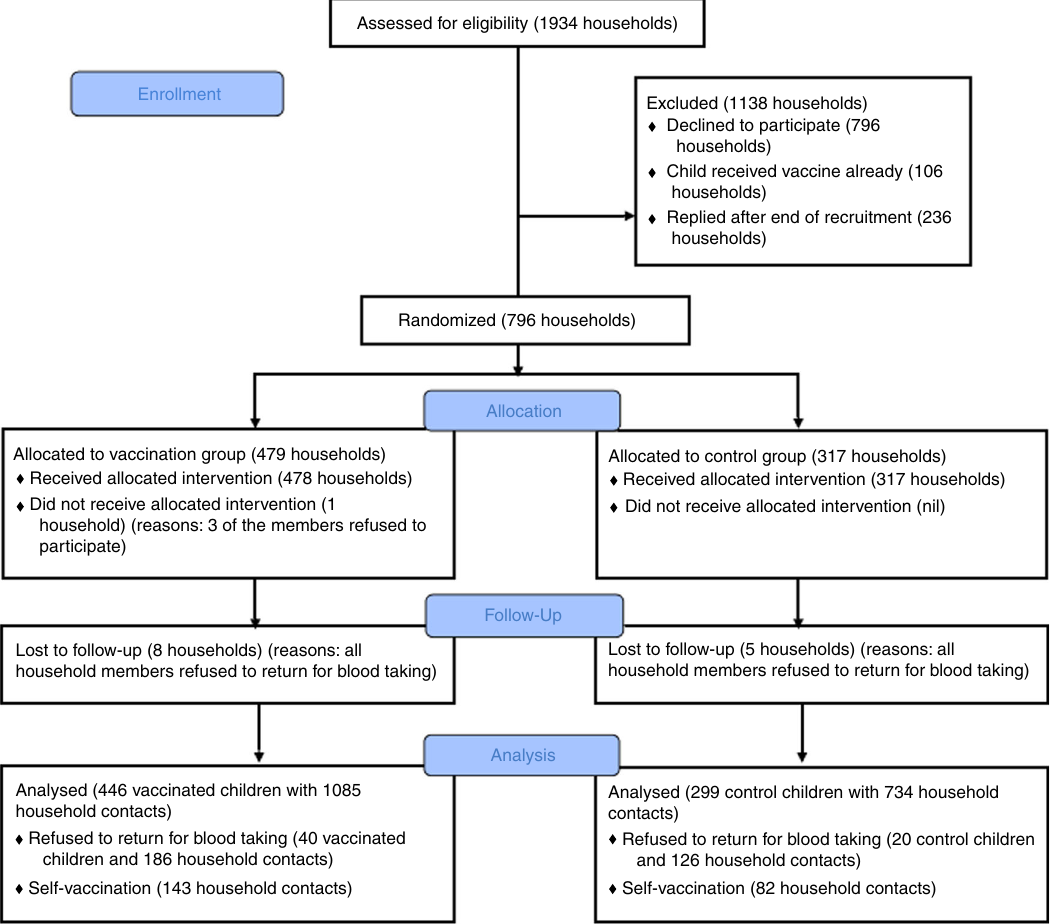
Fig. 1 Flow chart of participants in our study. Since our inferential framework is able to impute infection status, some of the individuals with missing fi nal outcome could nonetheless be included in the analysis. We include households with at least one household members with paired sera that covered the